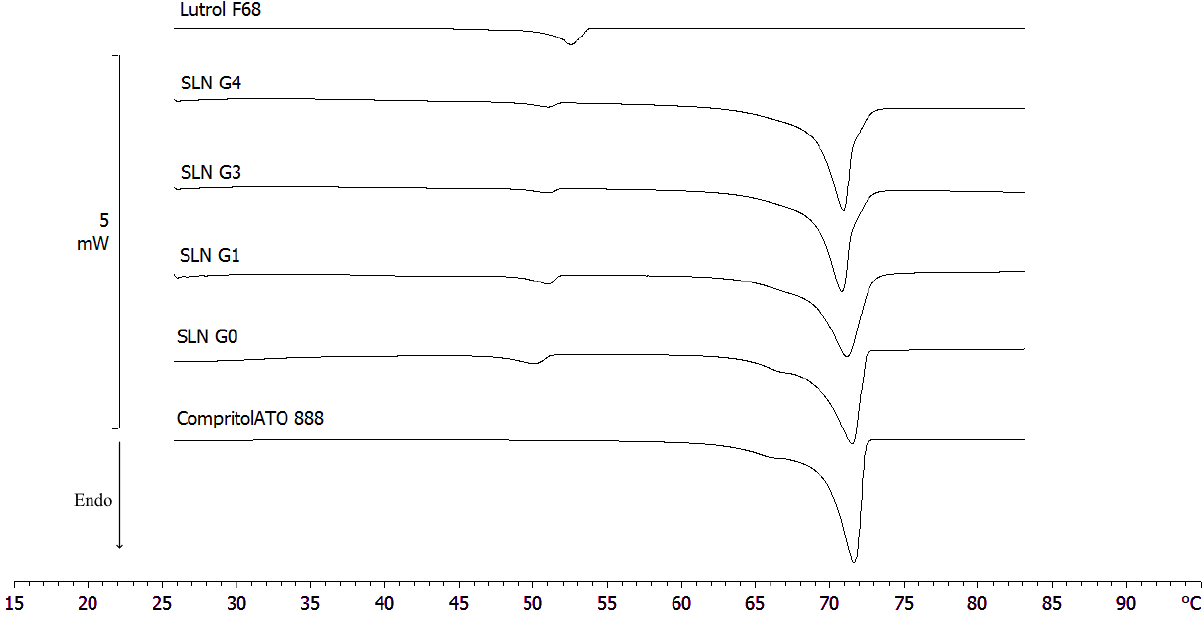
Figure 6. DSC thermograms of raw Compritol 888 ATO, Lutrol F68 and lyophilized SLN samples. Table 4. Enthalpy variations ( H) and peak temperatures of Lutrol F68, Compritol 888 ATO, and lyophilized SLNs.